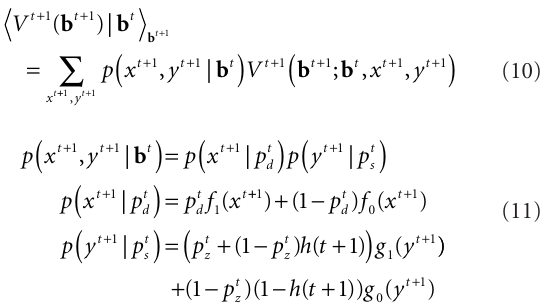
evidence. (B) Average action costs corresponding to going ( Q gt , see text) and waiting ( Q wt , see text), using the same sets of trials as (A) . The black dashed vertical line denotes the onset of the stop signal. A response is initiated when the cost of going drops below the cost of waiting. The RT histograms for go and error stop trials (bottom) indicate the temporal distribution of when the go cost crosses the stop cost in each simulated trial. Each data point is an average of 10,000 simulated trials. Error bar = SEM. Simulation parameters: q q used in all